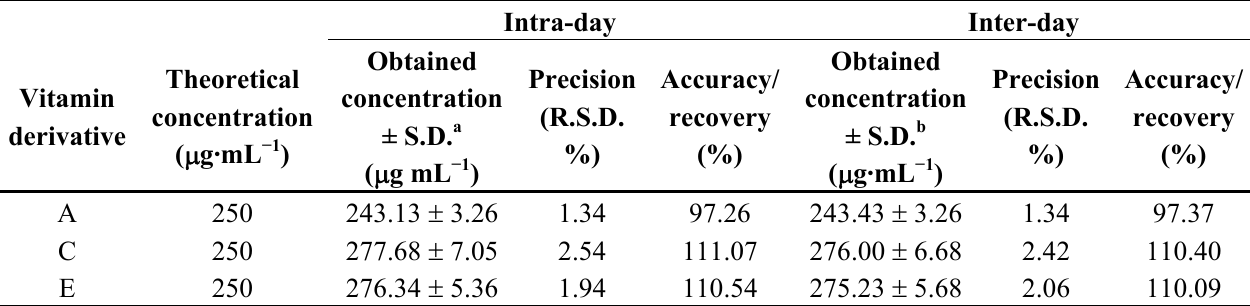
Table 1. Intra- and inter-days precision and accuracy/recovery (%) in the quantification of vitamins A, C and E extracted from experimental